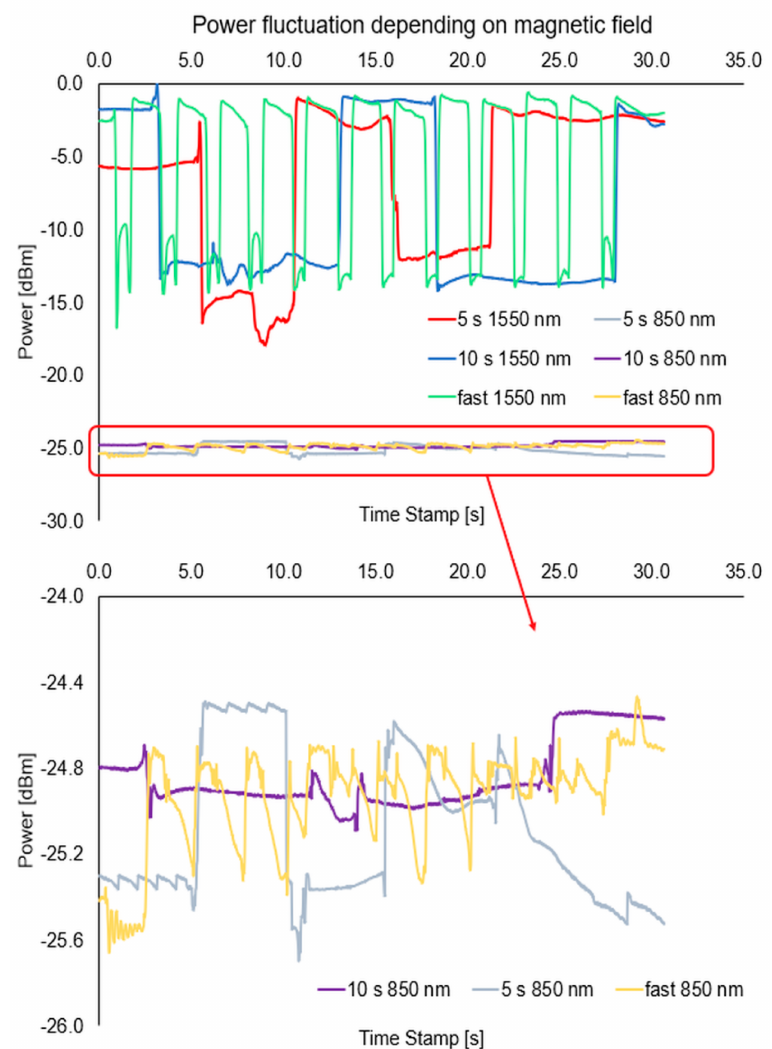
Figure 15. Power changes depending on the appearance and disappearance of a higher alkane with magnetic nanoparticles around the chosen region of an optical fiber taper by applying a magnetic field for 850 nm and 1550 nm wavelengths.